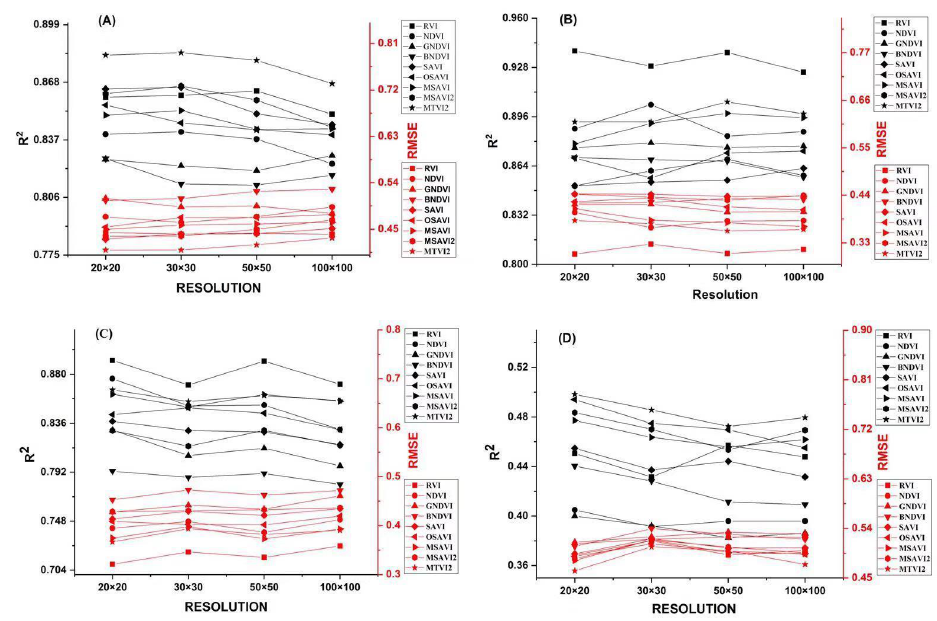
Figure 7. Best-fit model R 2 and RMSE that describe the relationship between spectral VIs and LAI with respect to the image resolution at the (a) seedling, (b) elongation, (c) flowering and (d) maturity stages.